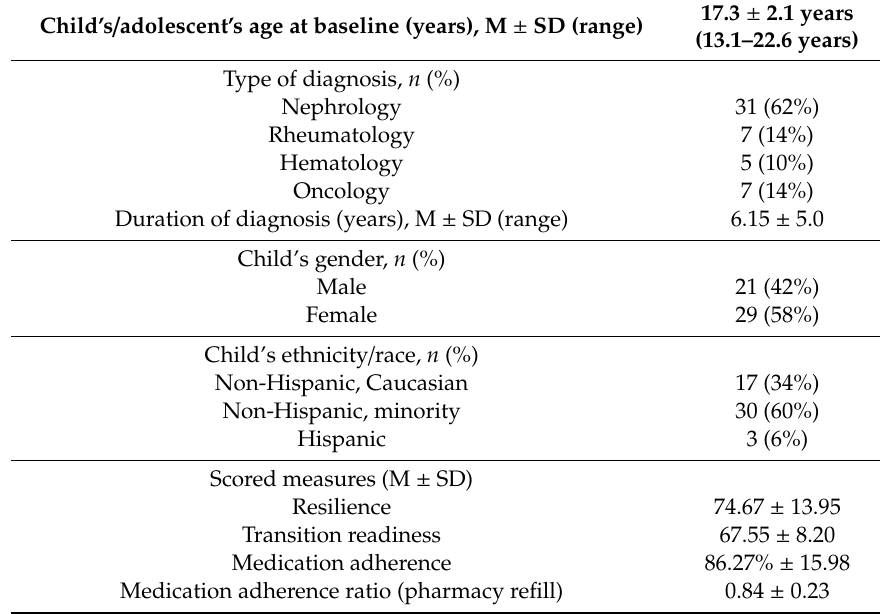
Table 1. Demographic and medical characteristics of baseline sample ( n =